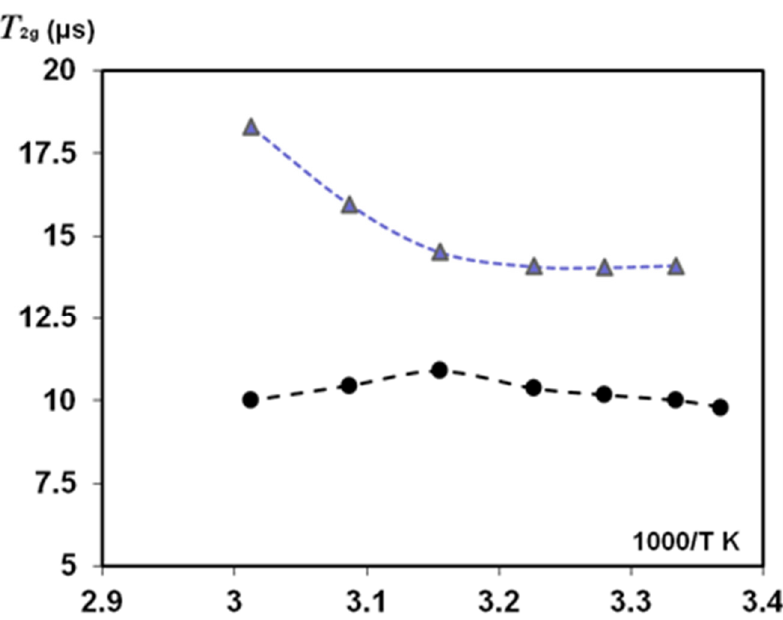
Figure 9. Temperature dependence of the apparent fast-relaxing T 2 component in two silk fibres B. mori samples (originally HL = 0.083); the samples were slowly heated in the NMR coil being measured after each 5–7 ◦ step. Dash lines provide guidance for the eye. (1) (Blue triangles) silk fibres with 90 ◦ orientation; (2) (Black circles) silk fibres with 0 ◦